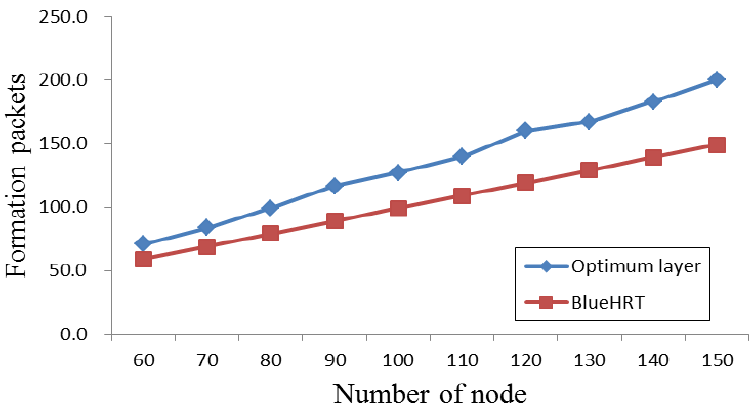
Figure 10. Average number of formation packets.